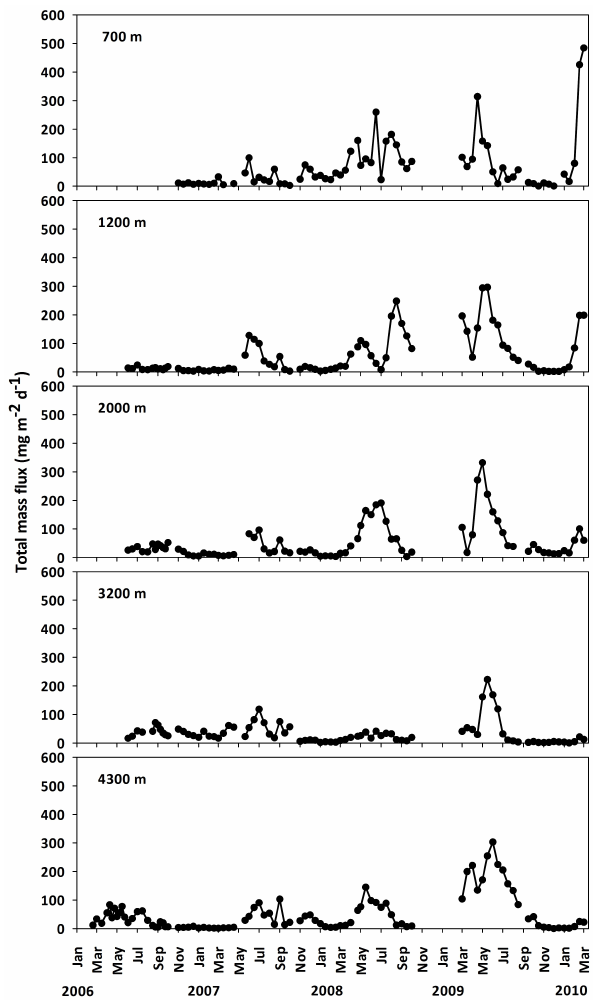
Fig. 4. Time-series plots of total mass flux (mgm − 2 d − 1 ) of down- ward settling particles collected by sediment traps during the course of the long-term experiment in NESTOR site.